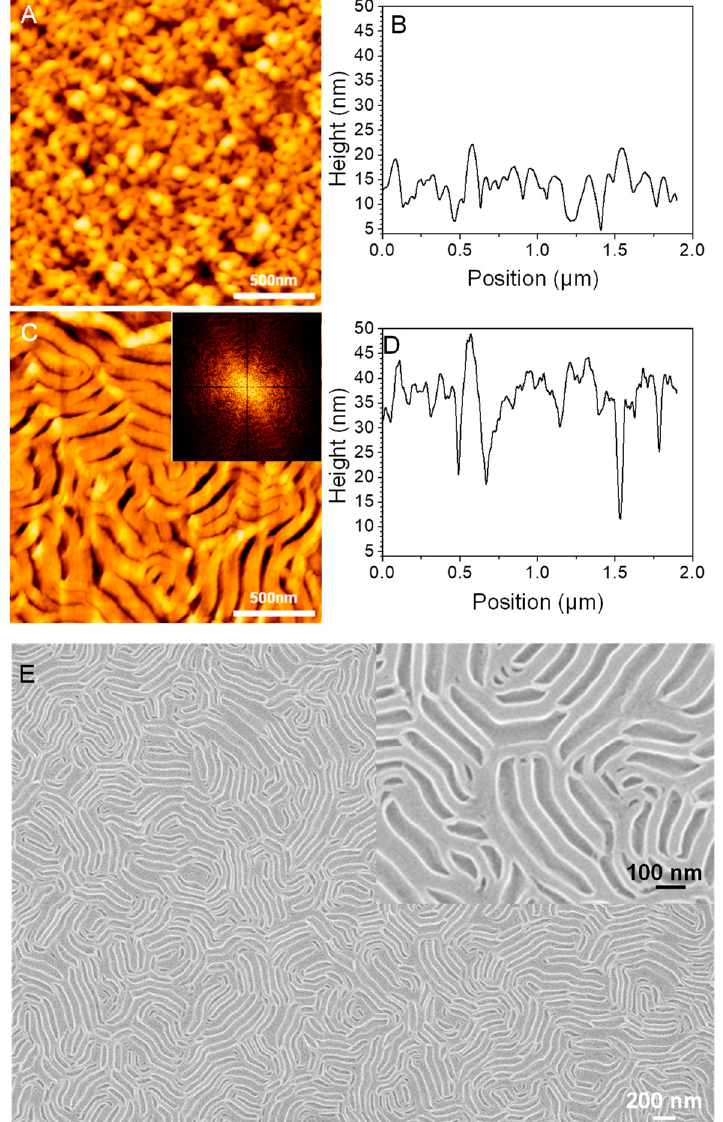
Figure 4. ( A , C ) AFM topographic images and ( B , D ) height profiles of neat P(S 21 -b-M 21 ) films (h i = 97 nm on PS 270n -SiO x /Si) with perpendicular lamellae. Prior to AFM characterization, the films were briefly immersed in acetic acid ( A , B ) without and ( C , D ) with UV-light irradiation of 5 h. The inset in ( C ) denotes the corresponding FFT pattern of Image C. ( E ) low-magnification SEM image of the same film of Figure 4A,B. The insert in ( E ) is a large-magnification SEM image.